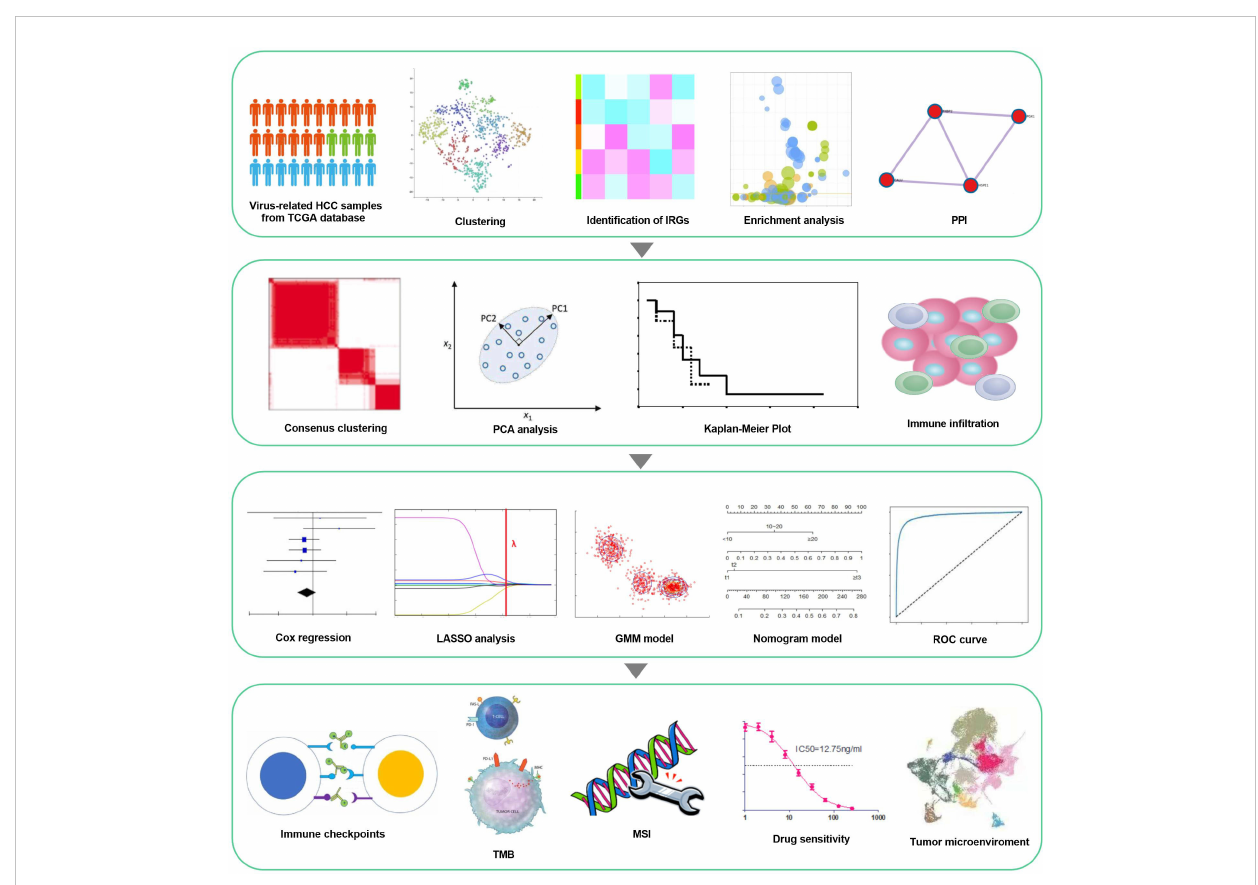
FIGURE 1 work fl ow of the study. Virus-related HCCs extracted from TCGA database and 200 in fl ammation-relevant markers from the Molecular Signatures database were analyzed to identify IRG DEGs. Next, consenus clustering was used to classify in fl ammation subgroups. The prognostic model was constructed and validated in multiple ways and proved to be stable and reliable. Therefore, based on this model, we also performed analysis about immunological characteristics, drug sensitivity and the correlation between IRGs and Tumor